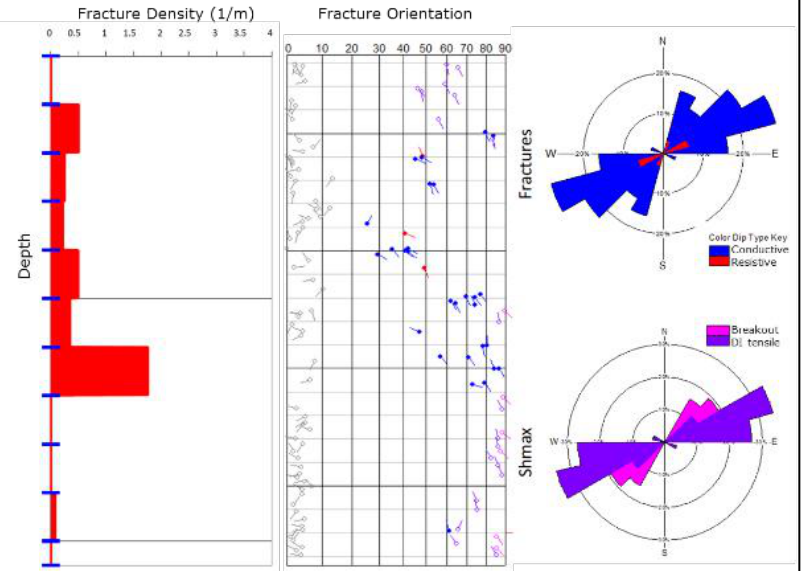
Figure 4—Fracture density and orientation interpreted from FMI image log from Well